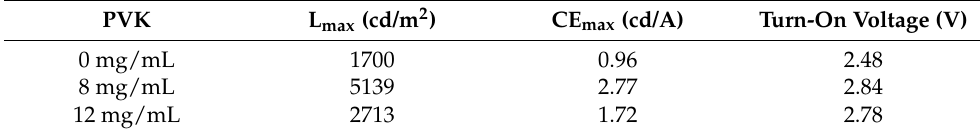
Table 2. Summary of the device parameters of PeLEDs with different concentrations of